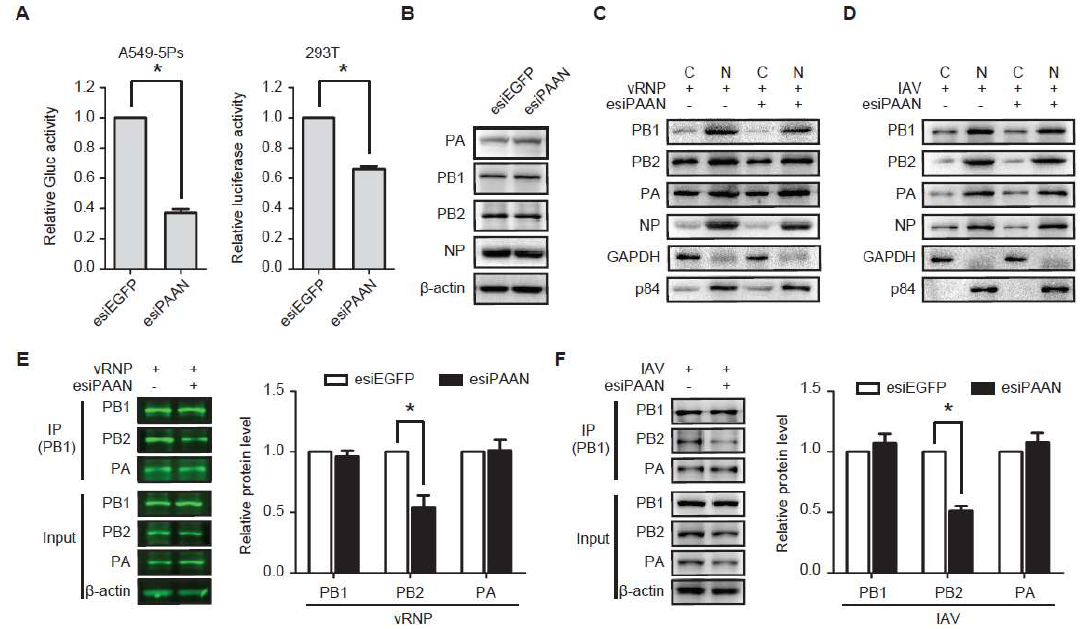
Figure 5. LncRNA-PAAN knockdown impairs PB1-PB2 association and the RdRp activity. ( A ) Gluc activities were determined in A549-5Ps cells that were transfected with esiPAAN or esiEGFP (left panel). Luciferase activities were measured in HEK293T cells that were transfected with esiPAAN or esiEGFP, followed by co-transfection of RNP reconstitution plasmids (PB1, PB2, PA, NP) and the reporter plasmid used to transcribe an IAV-like RNA (right panel); ( B ) A549-5Ps cells were transfected with esiPAAN or esiEGFP. Levels of viral PA, PB1, PB2 and NP protein were determined by western blotting; ( C , D ) HEK293T cells were transfected with esiEGFP or esiPAAN, followed by co-transfection of plasmid DNA encoding vRNP subunits (PB1, PB2, PA, NP and PolI-luc) ( C ), or infection with IAV (MOI = 0.5) for 24 h ( D ). Levels of viral PA, PB1, PB2 and NP in cytoplasm and nuclei were analyzed by western blotting. The GAPDH protein was used as a cytoplasmic marker, and p84 protein as a nuclear marker. ( E and F ) HEK293T cells were transfected with esiEGFP or esiPAAN, followed by co-transfection of plasmid DNA encoding vRNP subunits ( E ), or infection with IAV (MOI = 0.5) for 24 h ( F ). Cell lysates were immunoprecipitated with anti-PB1 antibody. The inputs and the PB1-immunoprecipitated samples were analyzed by western blotting with the indicated antibodies. The intensity of protein band was determined using the Odyssey infrared imaging system ( E ) and Image J program ( F ). Right panel represents relative levels of PB1, PB2 and PA in the immunoprecipitated samples, which were calculated by normalization to control groups. IAV means the WSN strain unless otherwise specified. *: p ≤ 0.05.